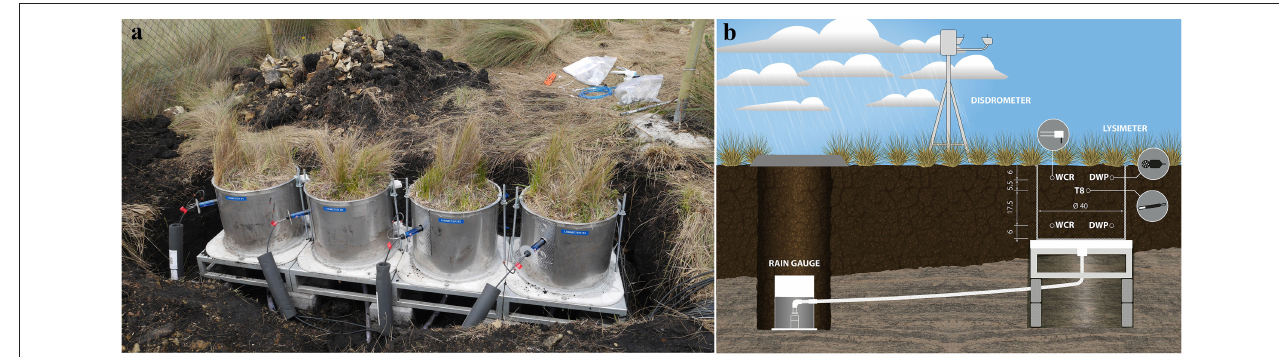
FIGURE 2 | (a) Lysimeters installed at the study site before they were covered by soil and vegetation. Sensors shown are T8 tensiometers. (b) Illustration of the lysimeter instrumentation (WCR, water content reflectometers; DWP, dielectric water potential sensors; T8, tensiometers). Dimensions are shown in centimeters.